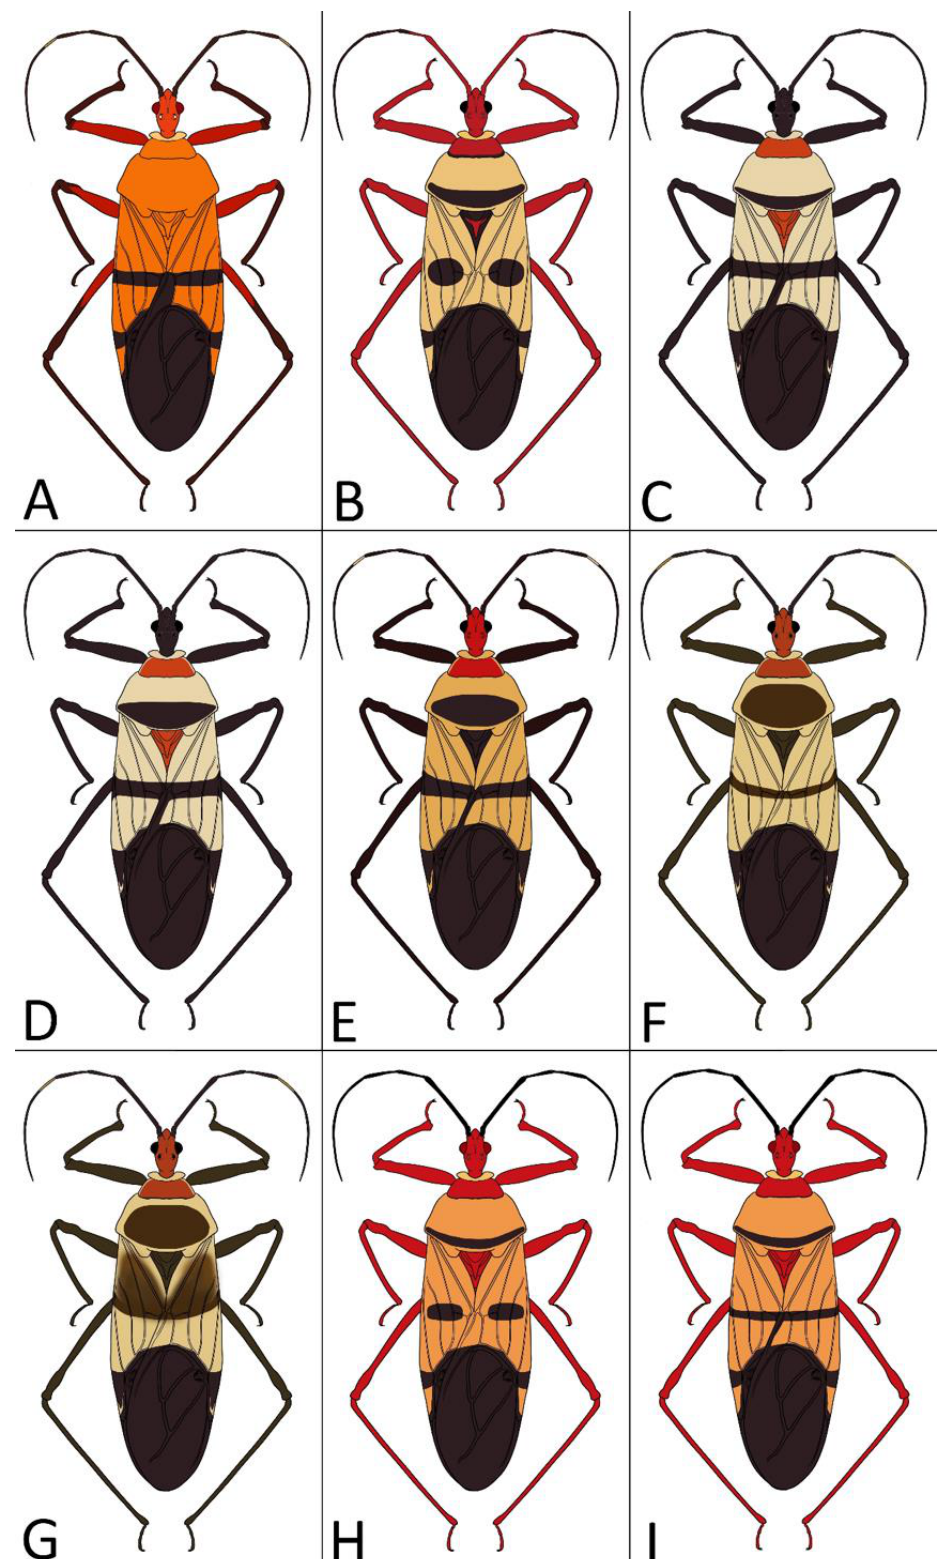
Figure 30. Dorsal colour patterns of the representatives of Phonoctonus Stål, 1853: ( A ) P. luridus Miller, 1950; ( B ) P. lutescens (Guérin-Méneville & Percheron, 1834); ( C , D ) P. nigrofasciatus Stål, 1855; ( E ) P. picta Schouteden, 1932; ( F , G ) P. picturatus Fairmaire, 1858; and ( H , I ) P. principalis Gerstaecker, 1892.